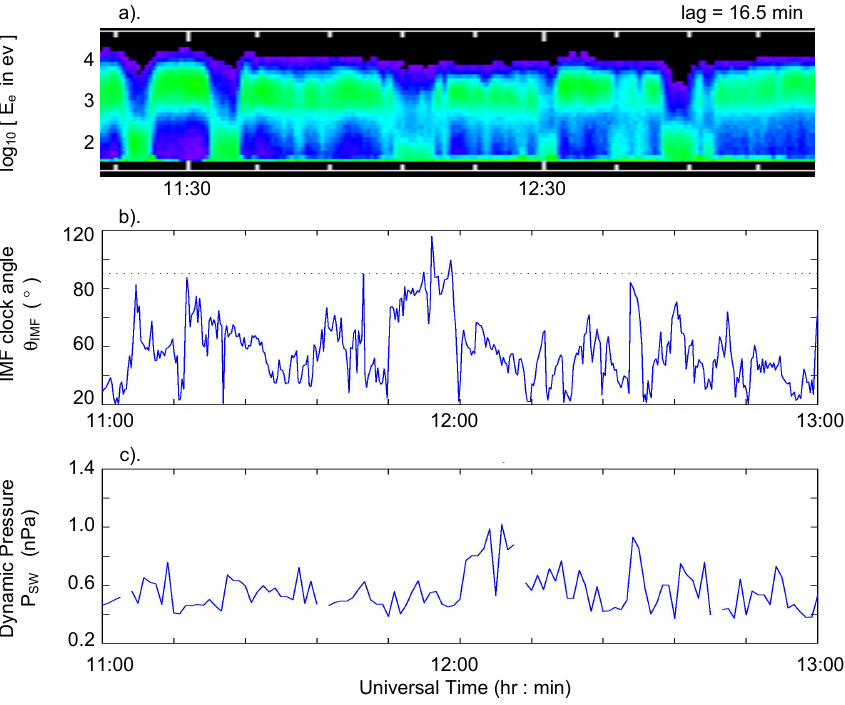
Fig. 3. (a) The PEACE data shown in Fig. 1d and compared with (b) the IMF clock angle θ IMF in GSM coordinates, as observed by ACE and (c) the solar wind dynamic pressure, P SW , also observed by ACE. The ACE data are plotted against lagged time, using the nominal 75min. lag derived independently by Lockwood et al. (2001, this issue) and Opgenoorth et al. (2001, this issue) for, respectively, before and after the period of interest in this paper. An additional lag of 16.5min has been introduced to obtain a good correspondence between the transient LLBL entries seen by Cluster and the increases in θ IMF to near 90 ◦ .